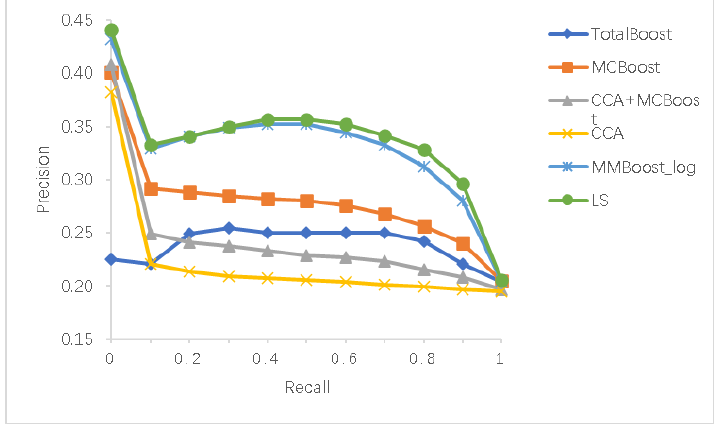
Figure 9. Precision–recall curves for image retrieval